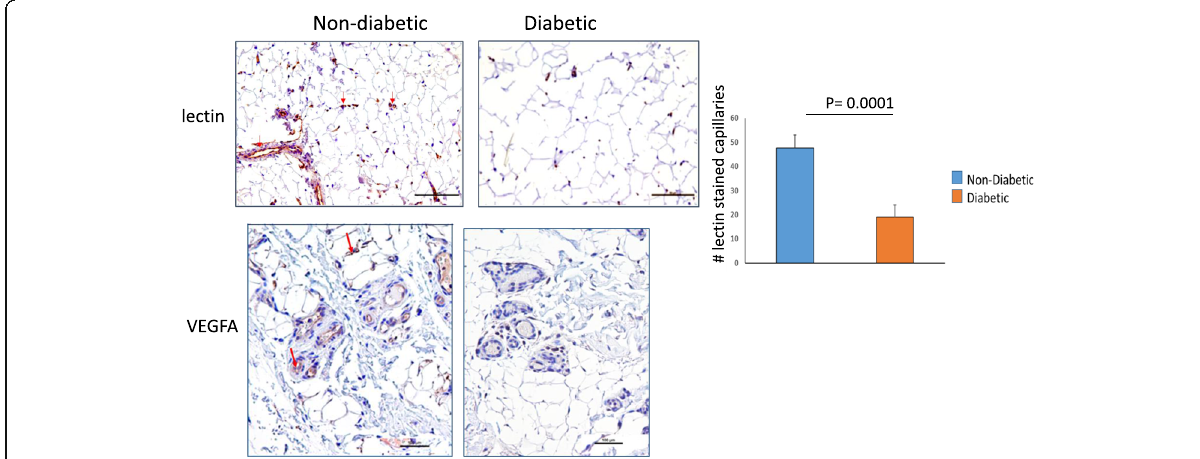
Fig. 4 Immunohistochemical staining on muscle biopsy samples taken at day 7 after FAO. Lectin stained sections below show more staining for lectin (brown chromogen) for the non-diabetic pig compared to the diabetic pig (magnification × 200). The bar graph on the right shows mean ± SD for quantification of the lectin stained capillaries for all biopsy specimens in the two groups of pigs. The non-diabetic pigs had significantly higher lectin staining. The second set of sections shows greater staining for VEGFA (brown chromogen) in the non-diabetic compared to diabetic